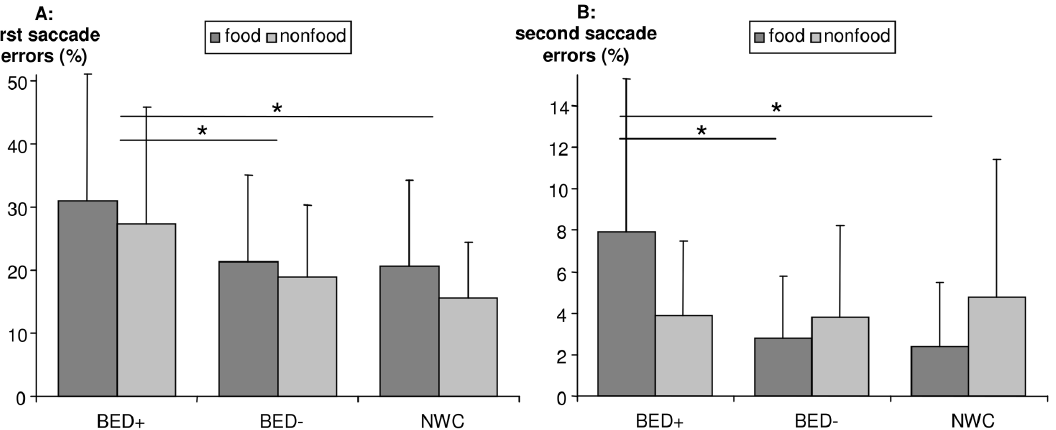
Figure 3. The percentage of first saccade errors (A) and the percentage of second saccade errors (B). Figures showing means and standard deviations. Panel A: Significant group and stimulus main effects (both p , .05) were found with significant differences between BED + and BED 2 and BED + and NWC in planned contrasts for the group effect (both p , .05, marked as *). Panel B: A significant group 6 stimulus interaction ( p , .05) was found with significant differences in planned contrasts between BED + and BED 2 and BED + and NWC (both p , .05, marked as *). BED + , overweight or obese women with binge eating disorder; BED 2 overweight or obese women without binge eating disorder; NWC, normal-weight control women.